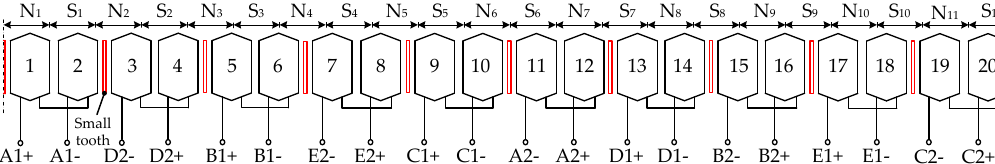
Figure 2. The stator windings outspread diagram of the five-phase PMSM.